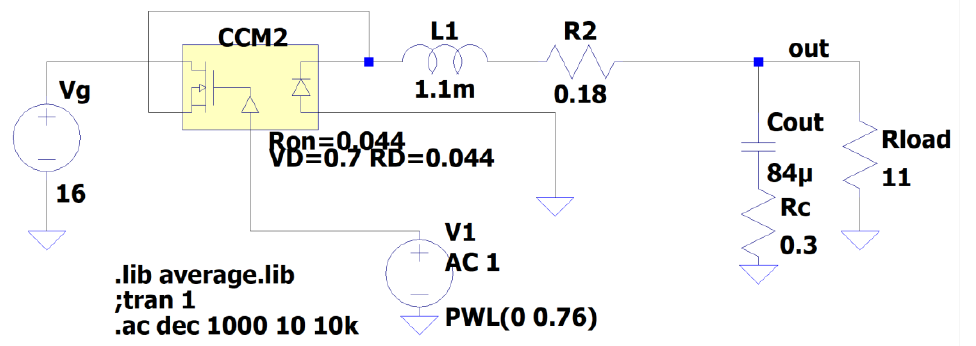
Figure 14. Averaged model of a practical buck converter.